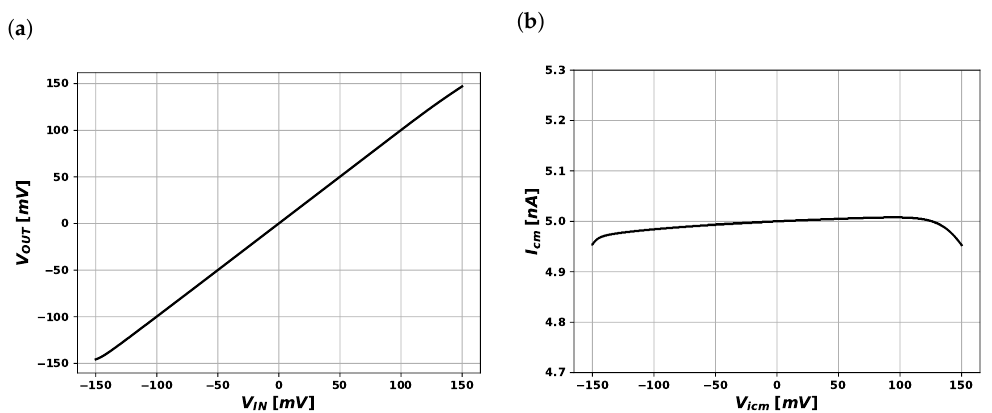
Figure 5. Open-loop differential gain frequency response: magnitude ( a ) and phase ( b ).